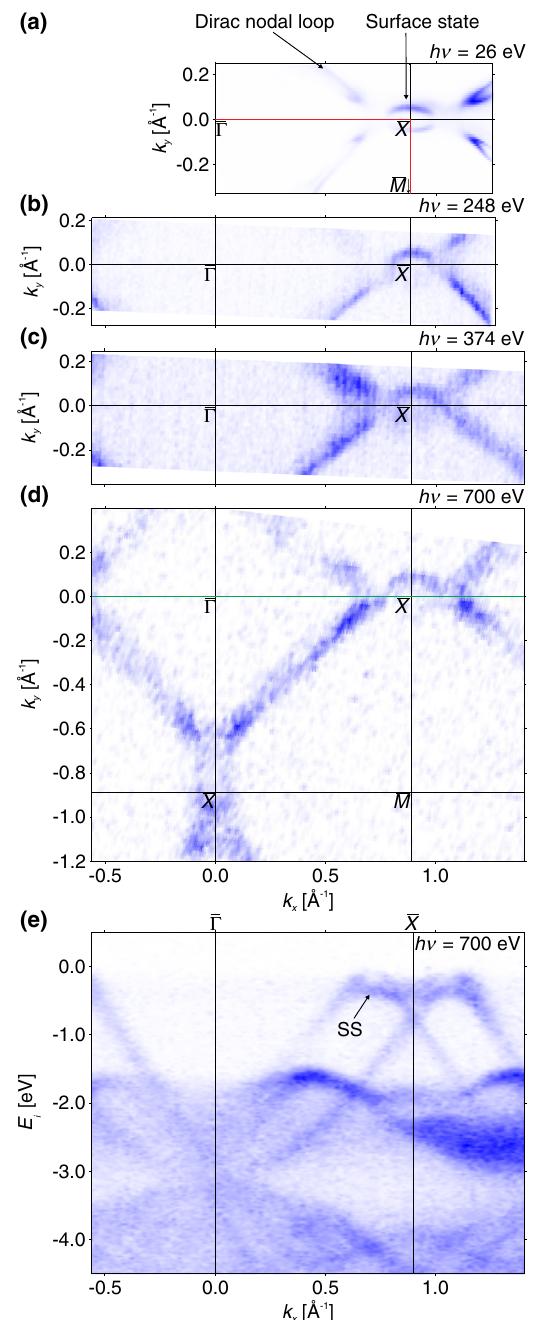
FIG. 3. Constant energy plots at the Fermi level for photon energies (a) h ν ¼ 26 eV, (b) h ν ¼ 248 eV, (c) h ν ¼ 374 eV, and (d) h ν ¼ 700 eV. (a) The bare ZrSiS surface shows the right quadrant of the diamond-shaped Fermi surface as well as the surface-derived pockets around X . The path for the dispersion data in Fig. 2 is shown in red. Panels (b) – (d) show a similar surface for photon energies of 248, 374, or 700 eV, respectively. (e) Dispersion along Γ X for h ν ¼ 700 eV [green line in (d)]. The pockets around X are clearly visible in the Fermi surface and the dispersion, showing the considerable weight of these surface states even for high photon